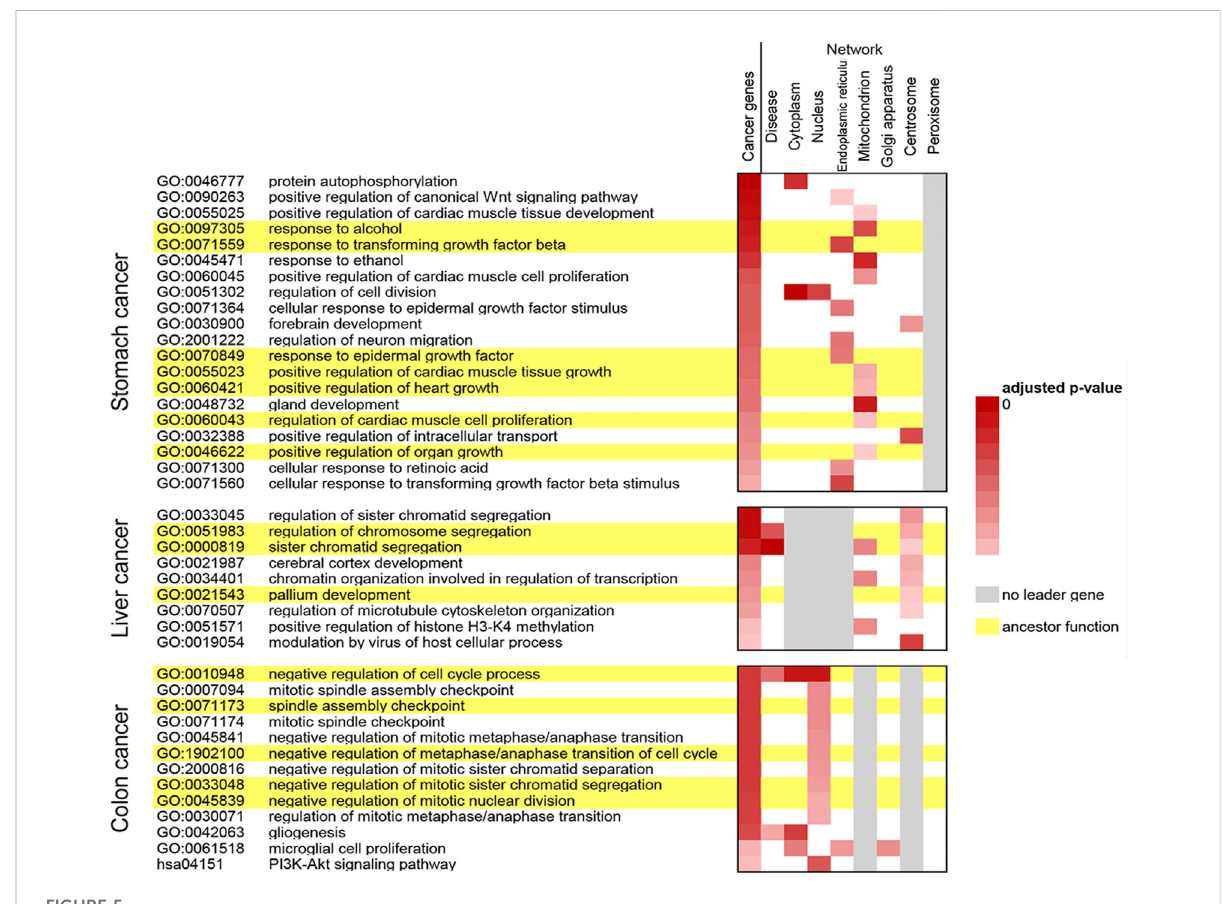
FIGURE 5 Functions enriched by cancer genes and leader genes from disease networks and from subcellular location-speci fi c networks. Lines in yellow represent ancestor functions, and columns in gray represent networks with no fi nal leader genes.